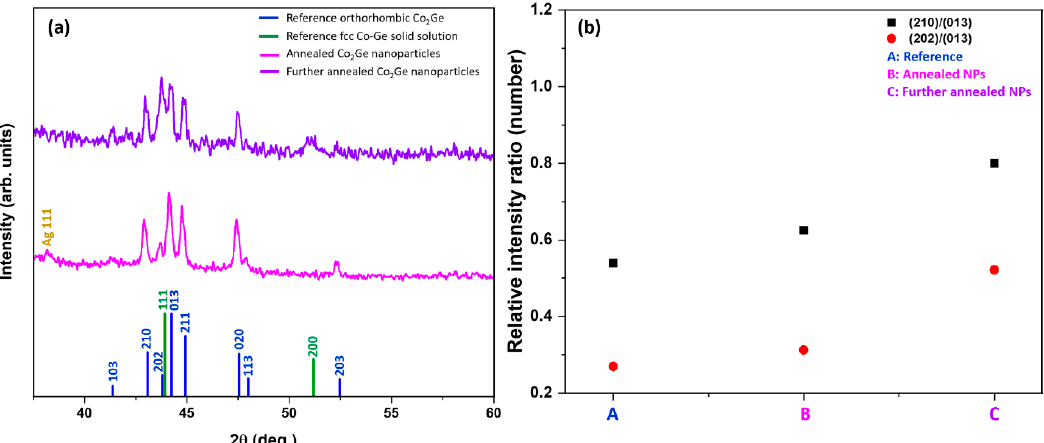
Figure 8. Structure of the annealed and further annealed NPS: ( a ) XRD data of the annealed and further annealed NPs as well as the reference XRD lines; and ( b ) the relative intensity ratios of (210)/(013) and (202)/(013) of XRD lines of the OP in all the annealed samples and reference lines.